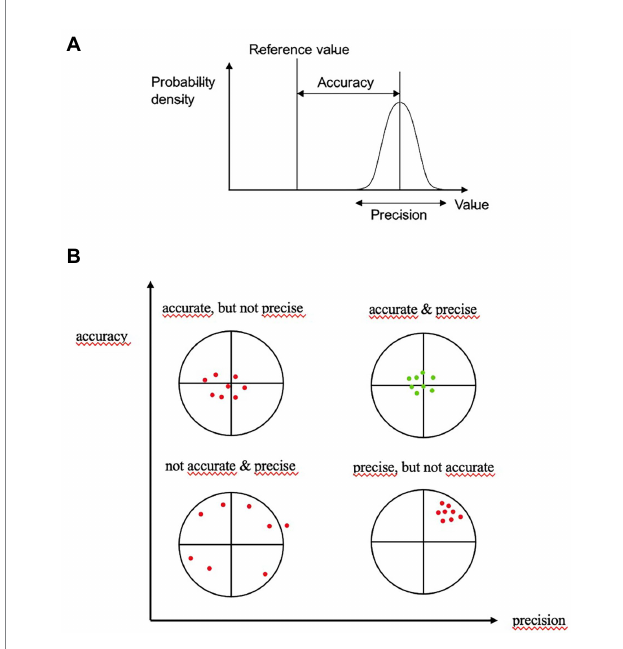
FIGURE 1 Accuracy is the proximity of assessments to the true value; precision is the degree to which repeated assessments under unchanged conditions show the same results. An ideal assessment should be accurate and precise (upper part Pekaje, creative common license wikimedia, https://commons.wikimedia.org/wiki/File:Accuracy_and_ precision.svg, downloaded 25th July,